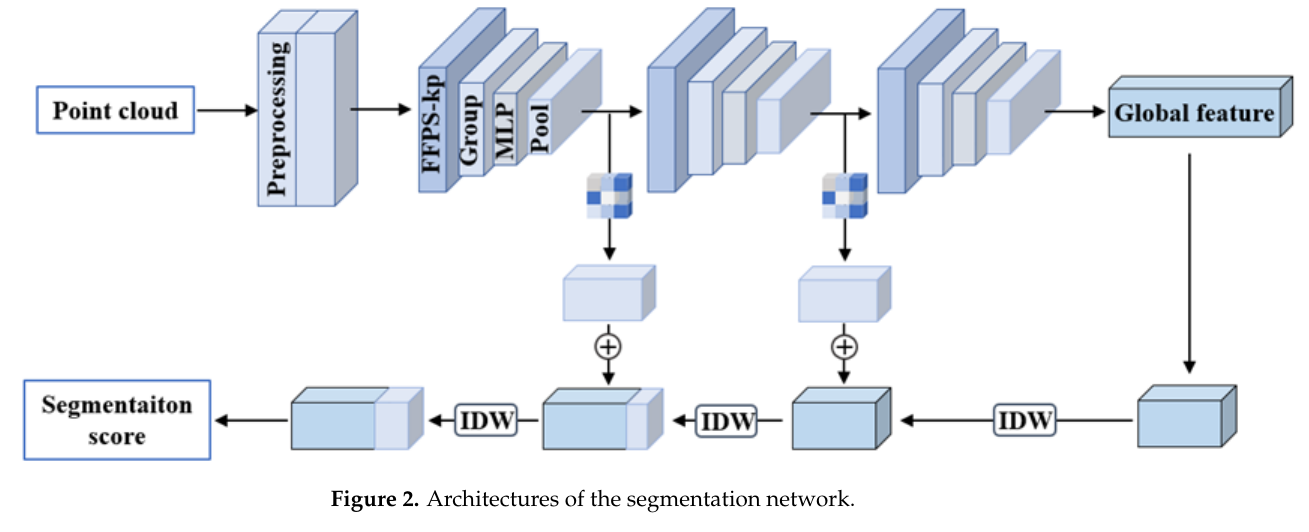
Figure 2. Architectures of the segmentation network.